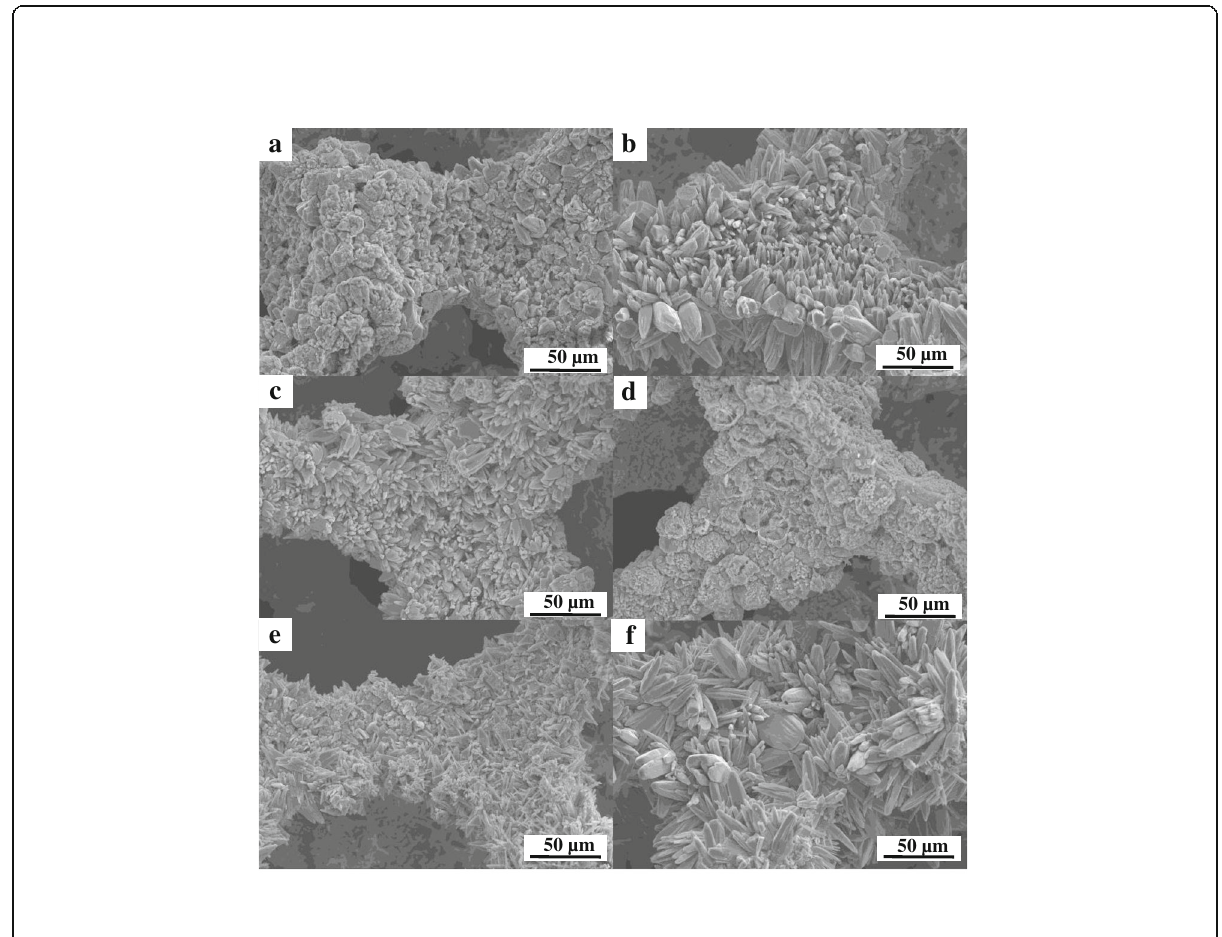
Fig. 6 SEM images of p -Co 3 O 4 / n -ZnO heterostructures grown on the surface of Ni substrate: a Co 3 O 4 /ZnO-5, b Co 3 O 4 /ZnO-15, c Co 3 O 4 /ZnO-25, d Co 3 O 4 /ZnO-35, e Co 3 O 4 /ZnO-45, and f Co 3 O 4 /ZnO-55,